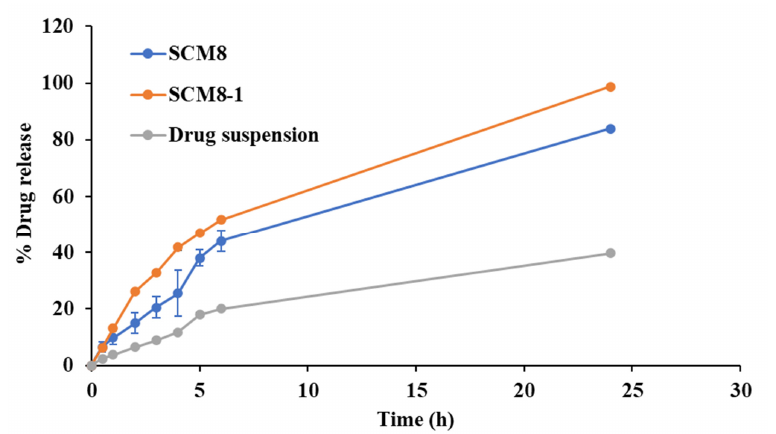
Figure 2. Response surface plots showing the effect of: TEOS percentage (TEOS %) and cryoprotect- ant percentage (CRY %) on Q 2 (a) and effect of cryoprotectant type (CRY Type) on Q 2 (b). The effect of aqueous phase percentage (Water %) and cryoprotectant percentage (CRY %) on Q 6 (c) and effect of cryoprotectant percentage (CRY %) and cryoprotectant type (CRY Type) on Q 6 (d).